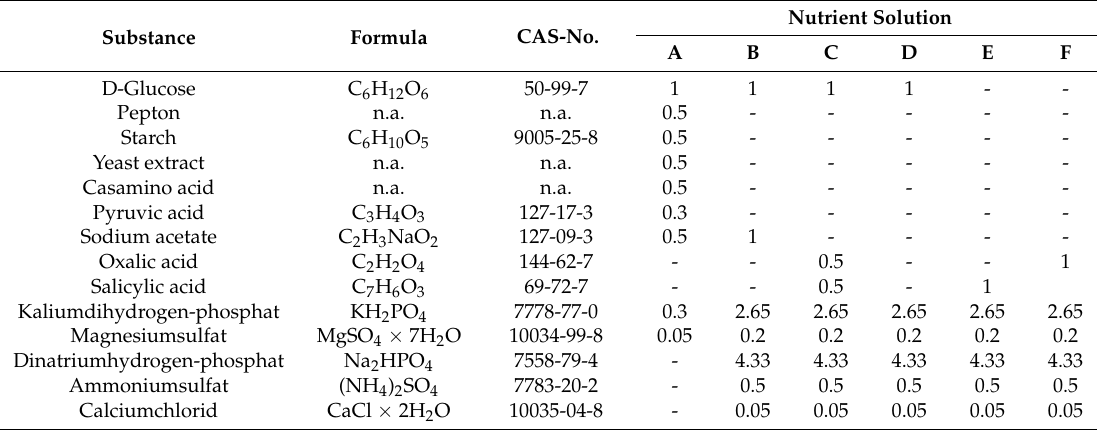
Table 1. Composition of culture media (in